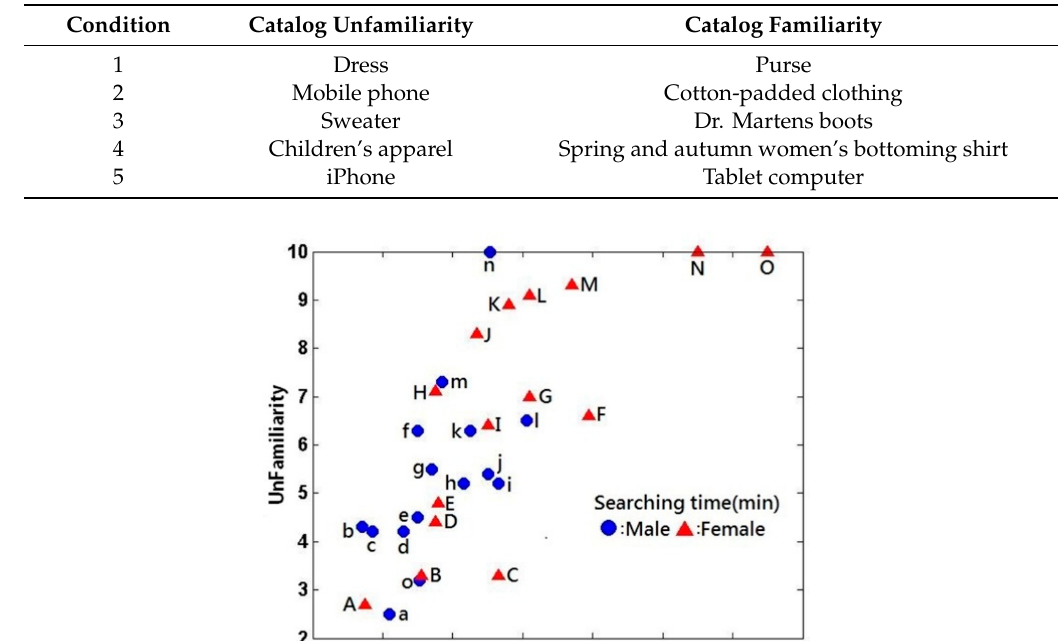
Table 11. Taobao’s best-selling products purchased not under time pressure.